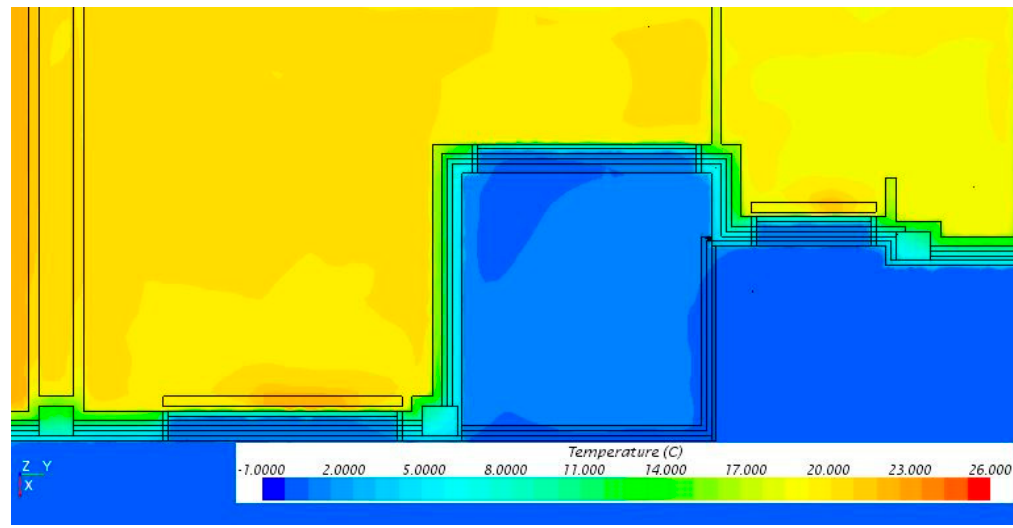
Figure 8. Temperatures shown in horizontal section of 1.7 m height on floor 1.